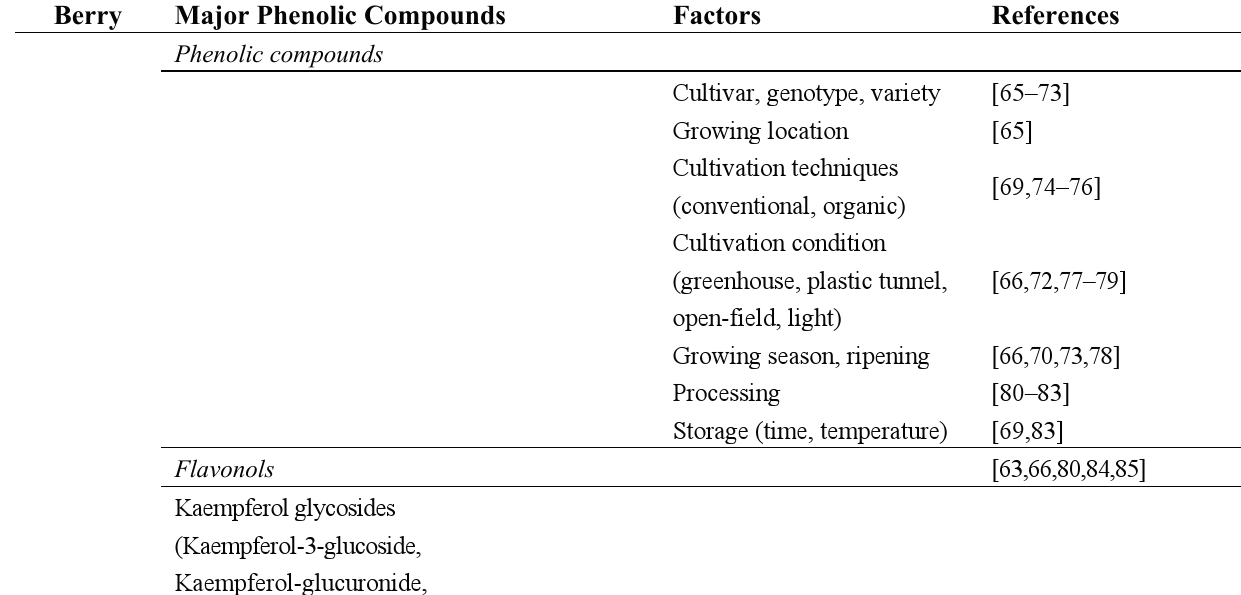
Table 1. Phenolic composition and factors influencing the composition of strawberries.